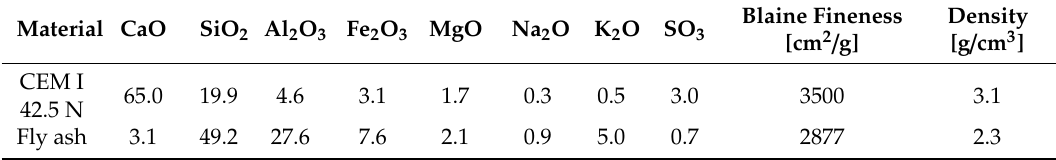
Table 1. Chemical composition and physical properties of the raw materials [wt.%].